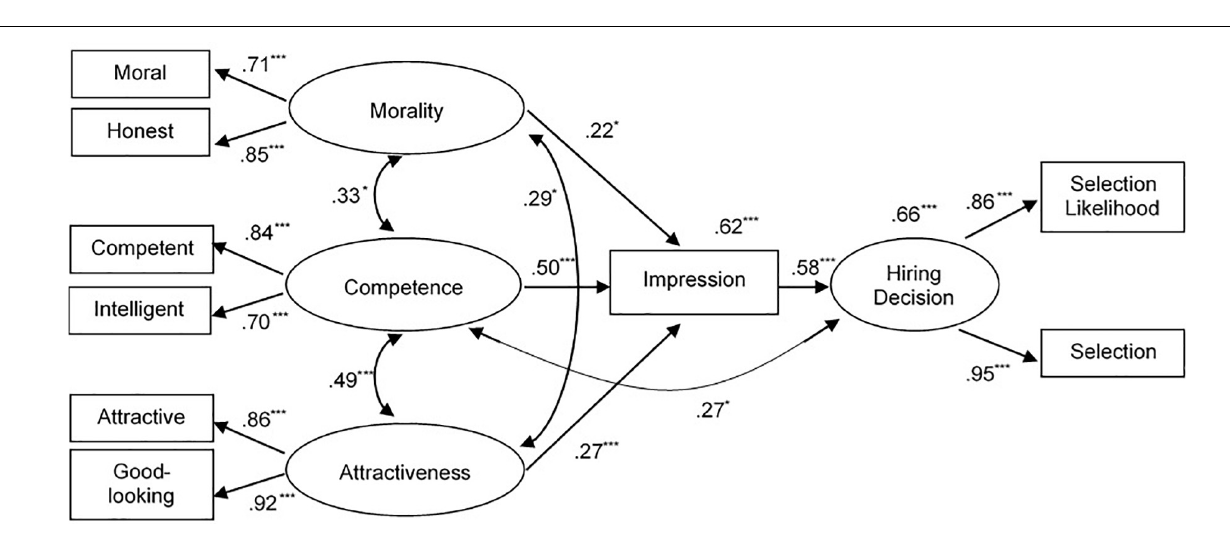
FIGURE 3 | Structural equation model for female applicants. Values reported above impression and hiring decision indicate portions of explained variance. * p < 0.05; ** p < 0.01; *** p <